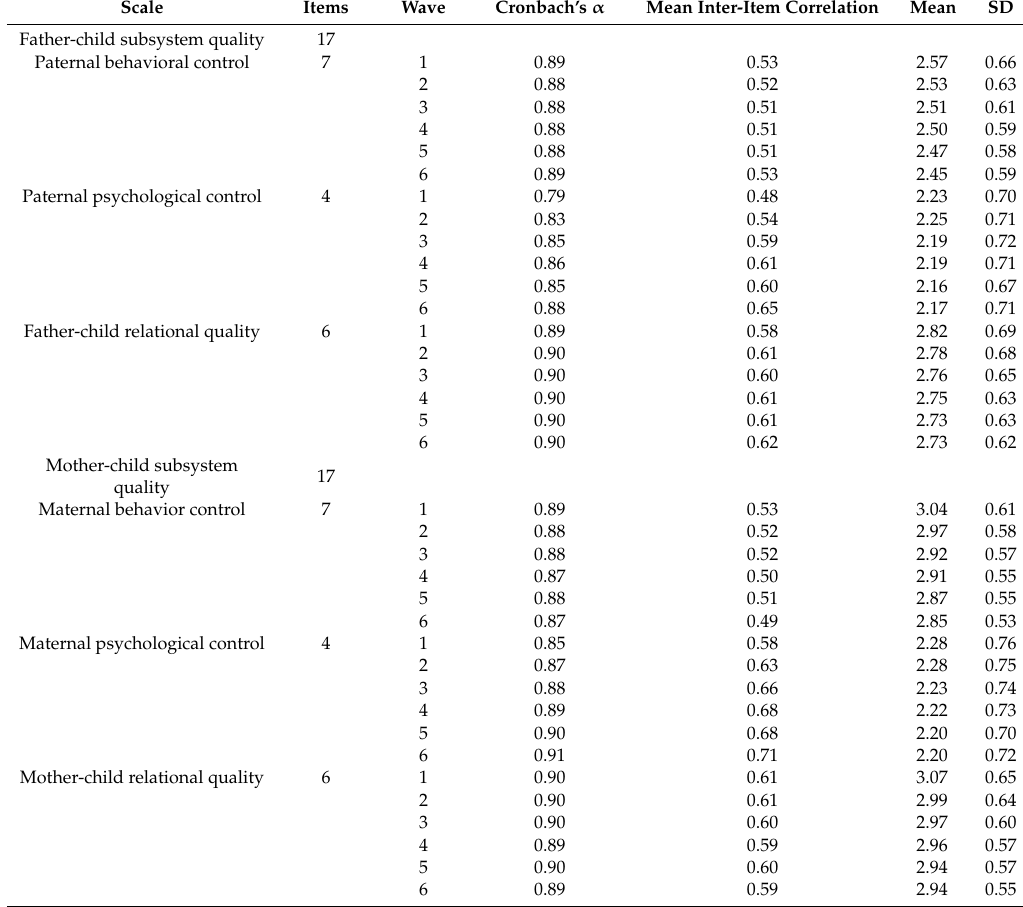
Table A1. Reliability of scales and descriptive results of variables across the six waves.